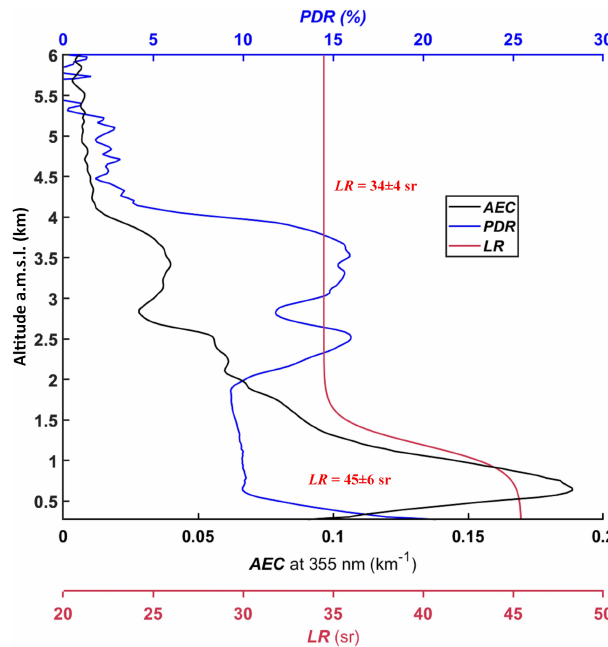
Figure 8. Mean vertical profiles derived from the ground-based li- dar between 19:00 and 22:00LT on 13 August 2011: aerosol ex- tinction coefficient (AEC), particle depolarization ratio (PDR), and lidar ratio